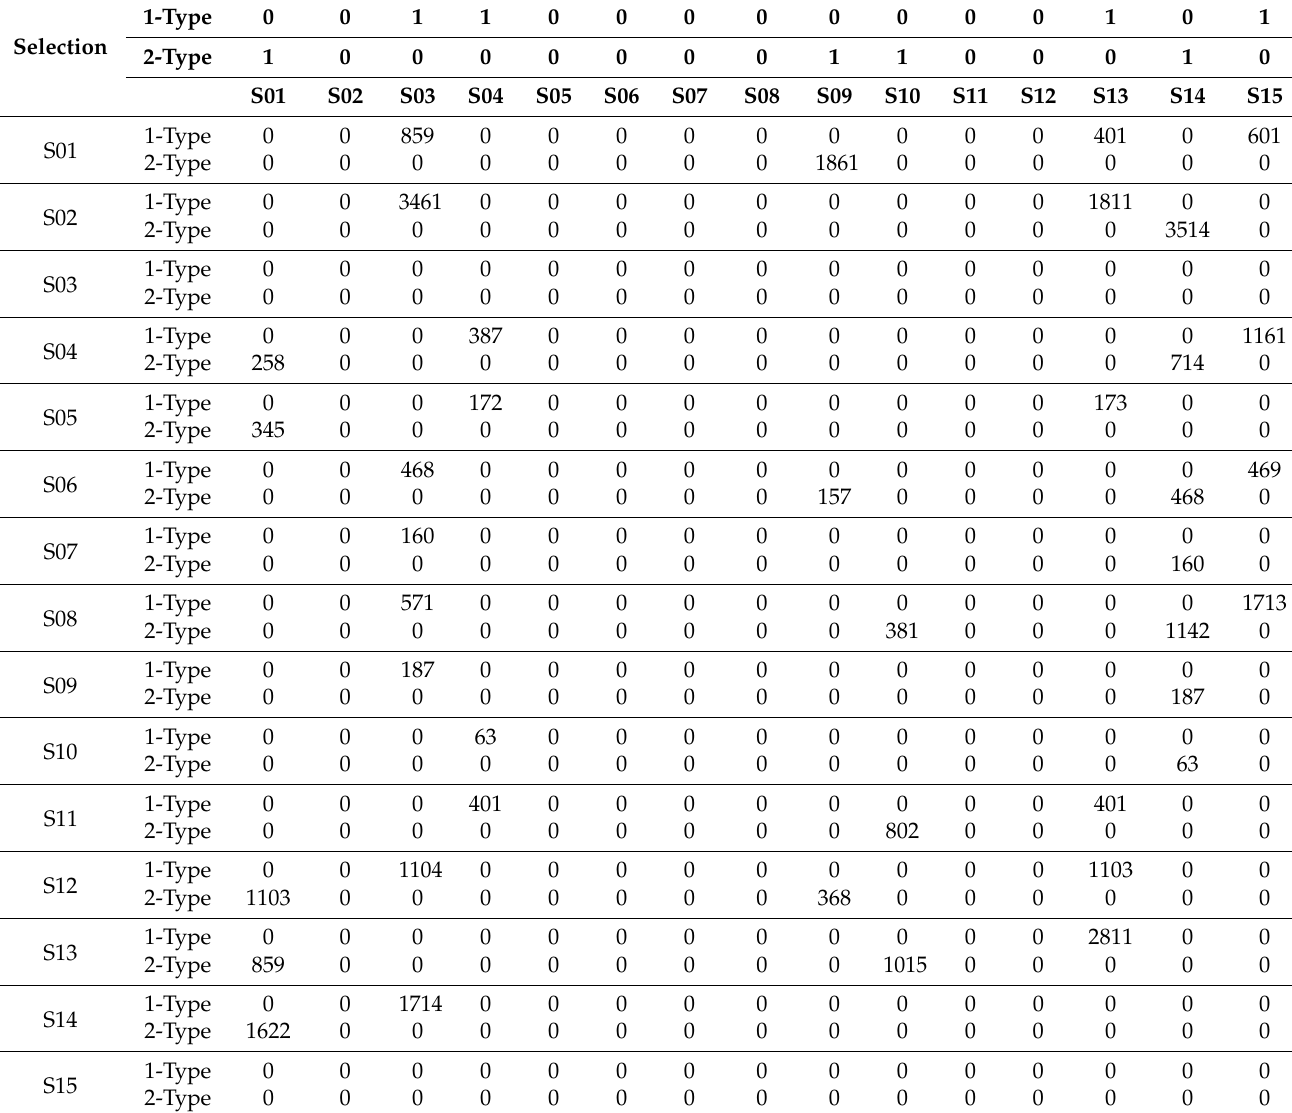
Table 19. Solution with the minimum number of short-term shelters to be open.